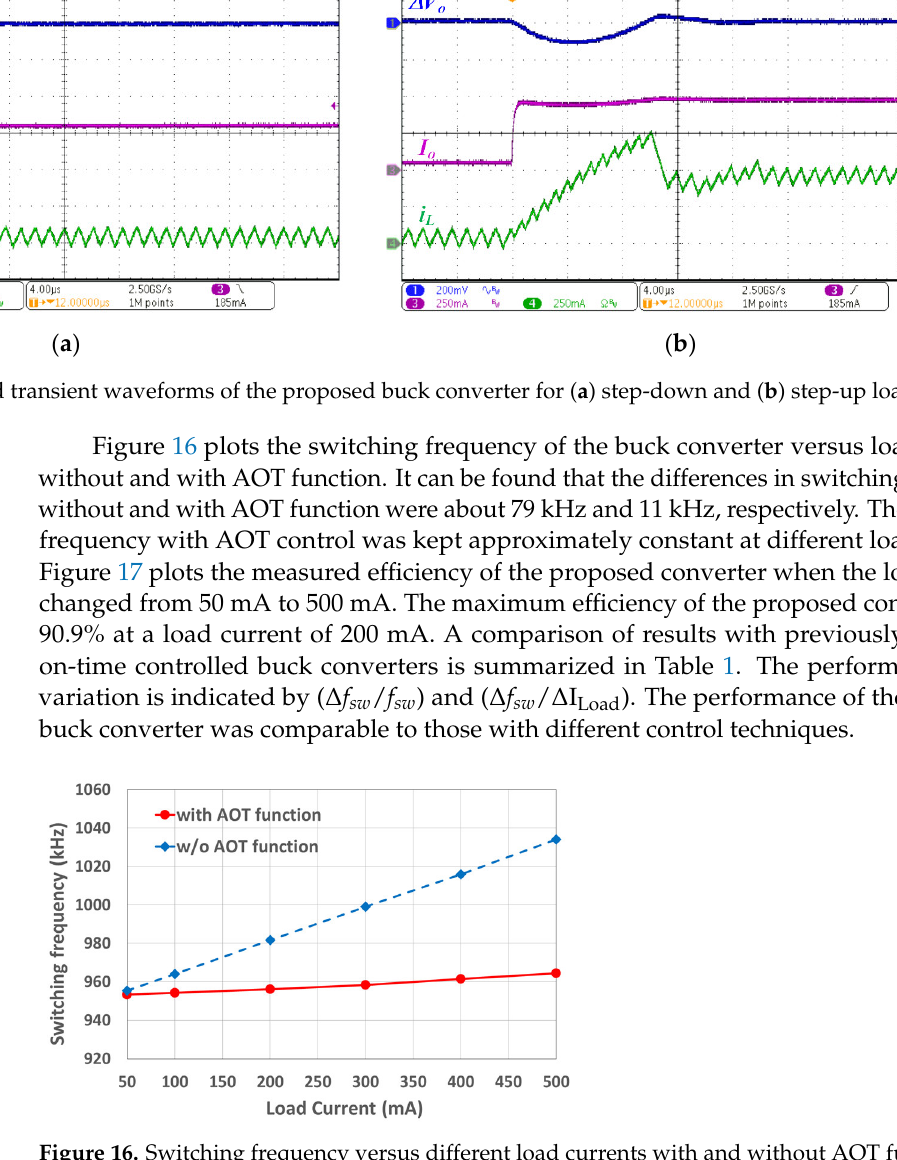
Figure 14. Output DC offset versus different load currents.